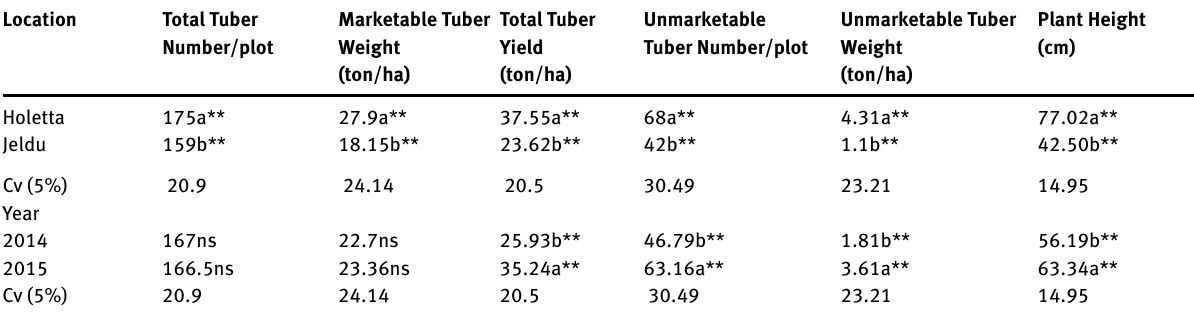
Table 1: Effect of growing Year and location on potato yield and plant height Location